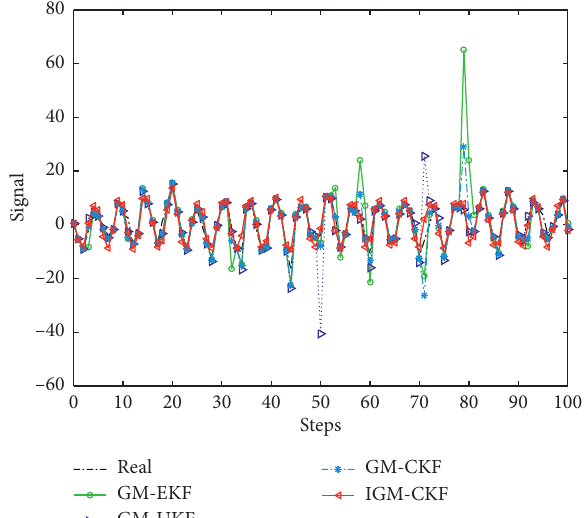
Figure 1: Various filtering algorithm